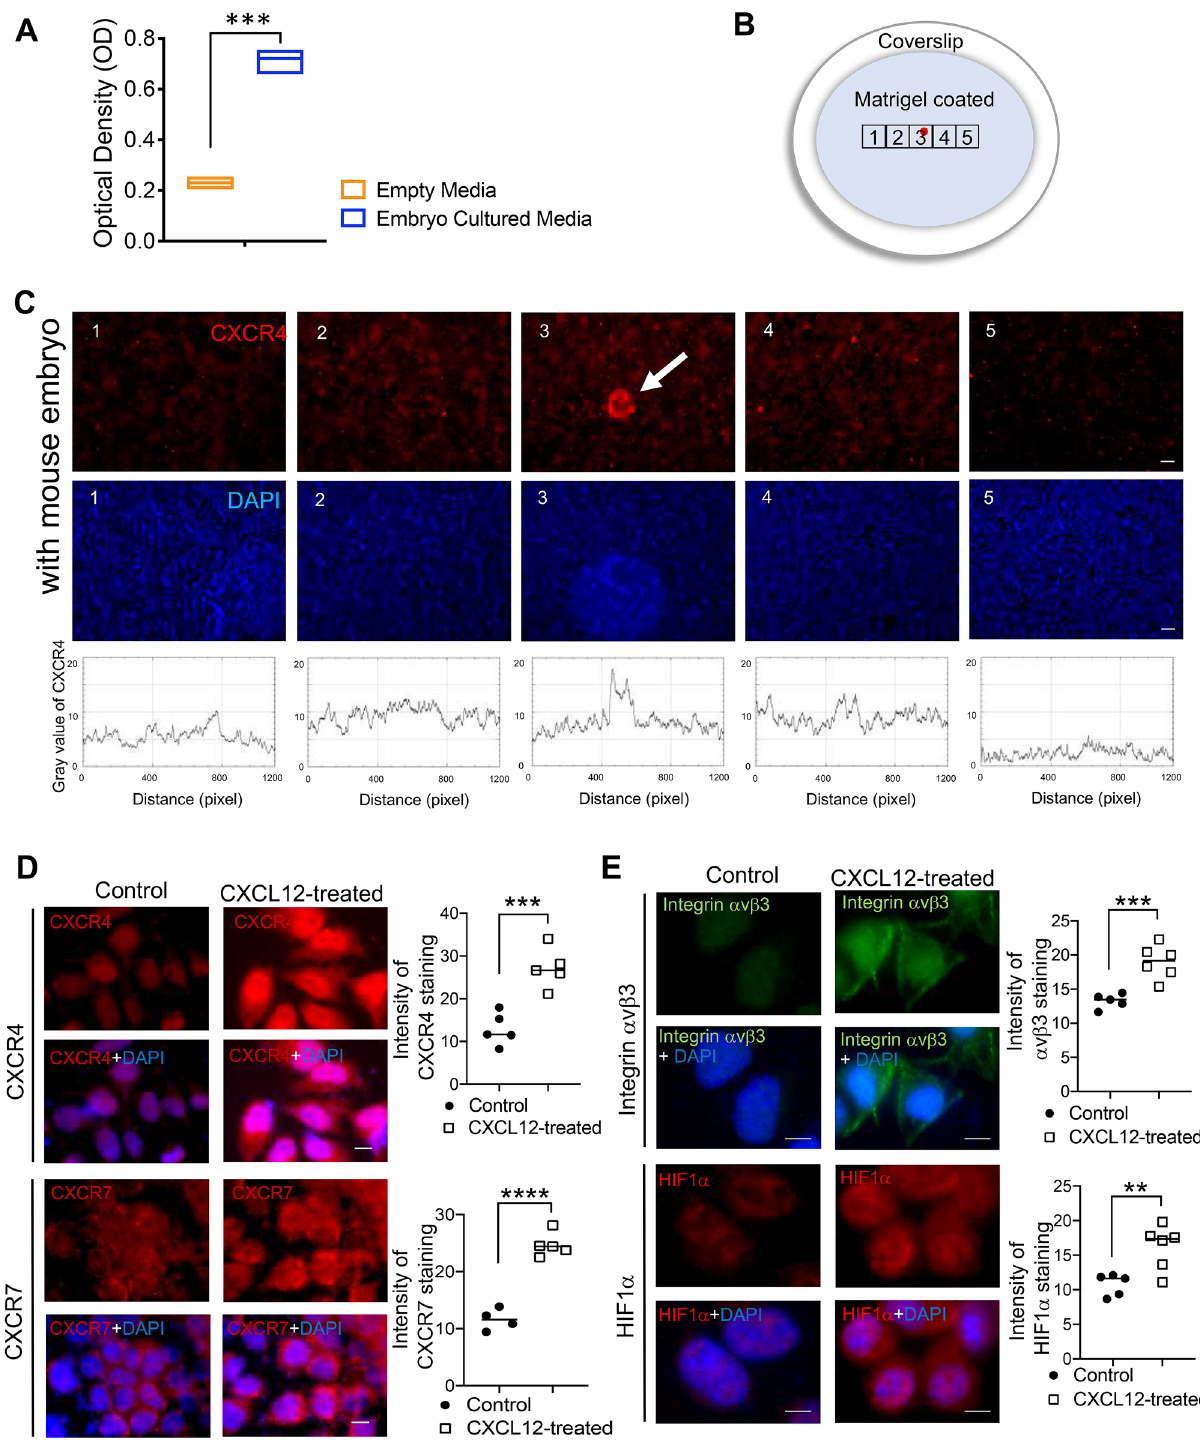
Figure 1. Embryo-derived chemokine CXCL12 and its receptor endometrial CXCR4/CXCR7. ( A ) CXCL12 levels were quantified in embryo culture or empty medium by ELISA. Comparison groups are from 3 independent experiments and analyzed using the unpaired Student t test for parametric distributions including p-values (***< 0.001). ( B ) A schematic diagram of co-culture system of mouse embryo with Ishikawa cells on Matrigel-coated coverslip. ( C ) Immunofluorescence (IF) staining images (1–5) were obtained from 5 different regions (illustrated on a diagram of ( B:1–5 )) of coverslip and mouse embryo (white arrow) was attached in the region number 3 (illustrated on a diagram of ( B ), marked as red spot). Red: CXCR4, Blue: DAPI. Scale Bar; 50 μm. Intensity of CXCR4 in each image was profiled. Images were captured at a magnification of 10 ×. IF staining of CXCR4, CXCR7 ( D ) and integrin ⍺ vβ3, HIF1 ⍺ ( E ) in Ishikawa cells in response to CXCL12. Saline-treated cells were used for control. Scale Bar; 20 μm. Intensity of IF staining was quantified using Image J and displayed in graphs. Data are from 4 independent experiments, and analyzed using unpaired Student t test analysis including p-values (*< 0.05, **< 0.01, ***< 0.001, NS; not